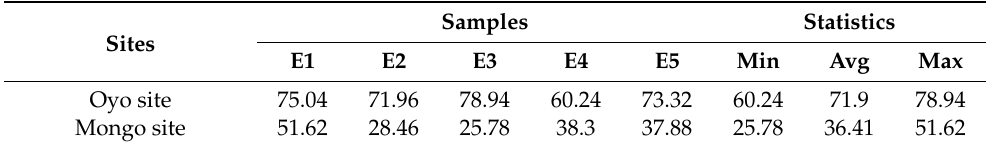
Table 5. Values of the LA coefficient in %, indicative of the resistance to fragmentation of solid grains on the 10/14 mm fraction of the Oyo and Mongo samples.